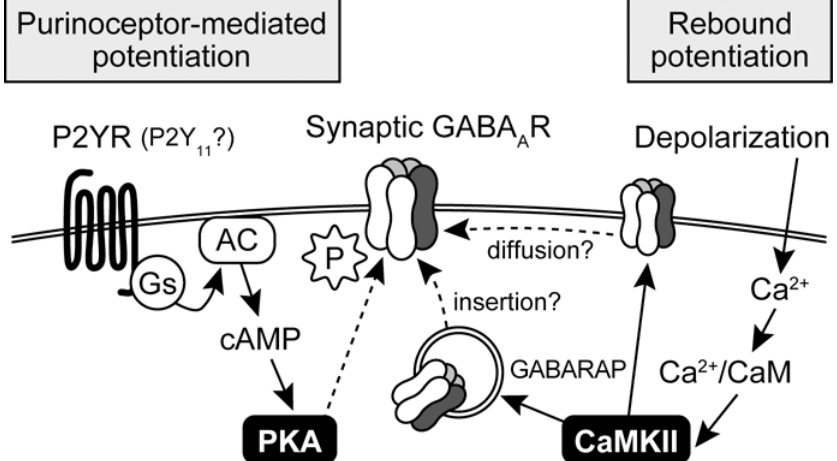
Fig 5. Schematic representation of different signaling cascades involved in the mechanisms underlying RP and PM-LTP. AC, adenylyl cyclase; CaM, Calmodulin; GABARAP, GABA A receptor- associated protein; P,